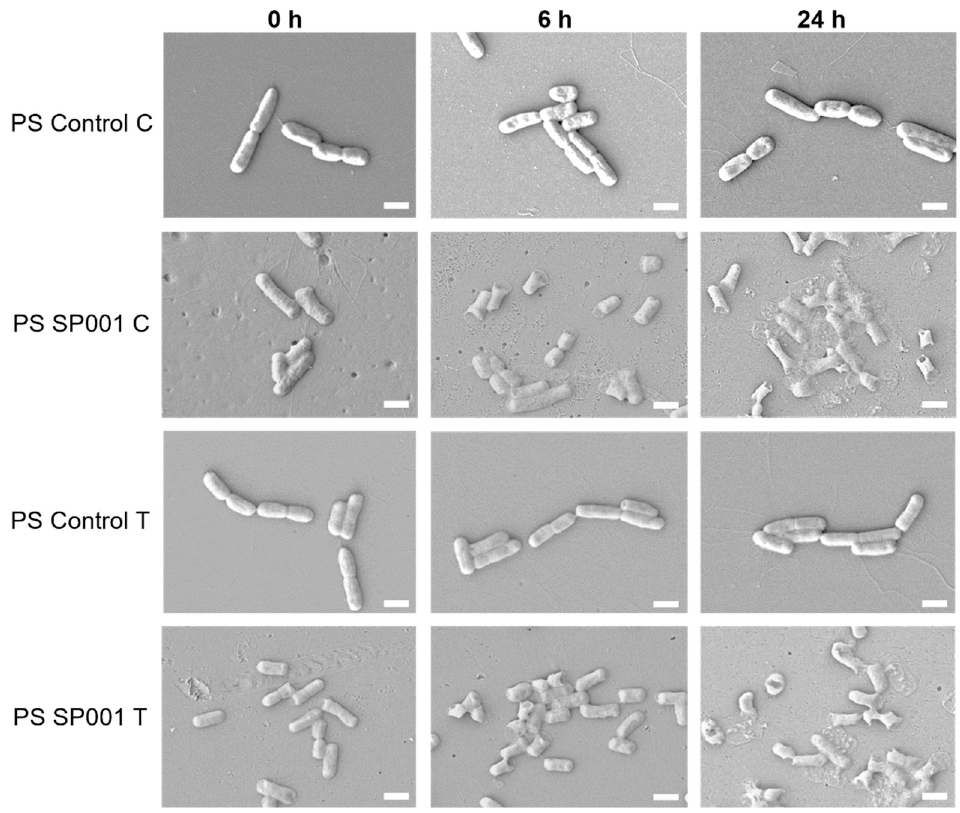
Figure 4. Bacteria morphology changes on PS*-1 surfaces. Cell morphology and viability of E. coli on PS-control and PS*-1 surfaces after 0 h, 6 h, and 24 h incubation determined using SEM. Scale bars, 1 µm.